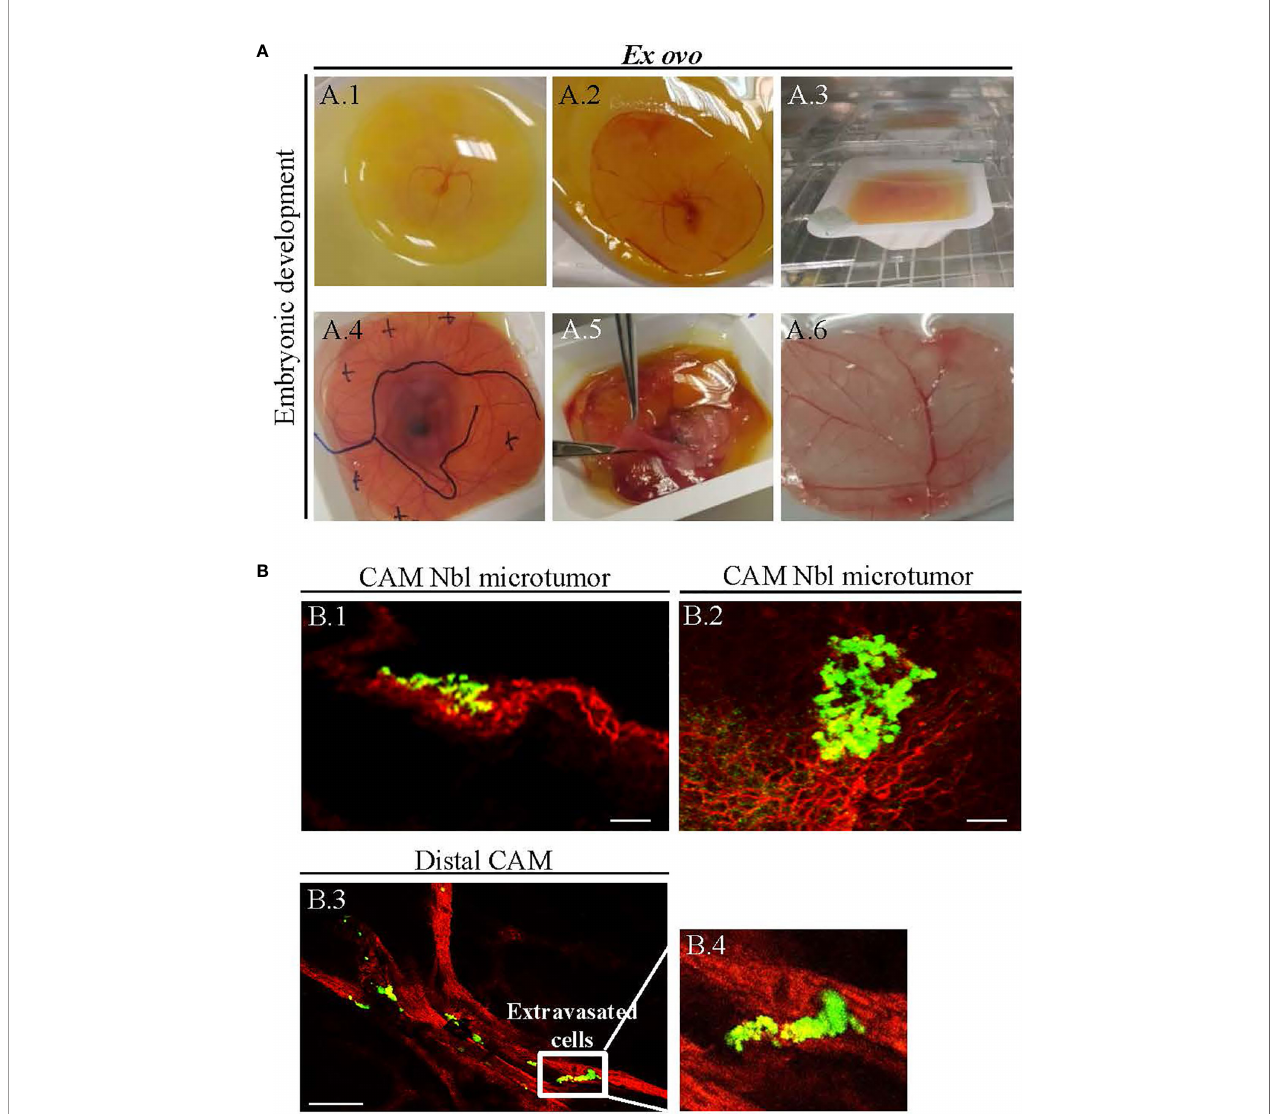
FIGURE 2 | (A) Ex ovo -cultivated chicken embryos exhibit physiological development over time. (A.1) Successful transfer of embryo having an intact egg yolk (on embryonic development day 3), and (A.2 – A.4) live embryo on embryonic development from day 3 to 10. (A.4) In vitro -cultured neuroblastoma (Nbl) cells were transferred on the chick chorioallantoic membrane (CAM) at day 10, and the sites of xenografting were marked on the cover of the Petri dish. (A.5) Harvesting of Nbl tumors from CAM at day 14. (A.6) The CAM fi xation for microscopy. (B) Confocal laser scanning microscopy (CLSM) validation of successful establishment of UKF- NB-4 xenografts on CAM. (B.1, B.2) Fluorescence angiography showing Nbl microtumors (green, labeled with CellTracker) surrounded by extensive amount of blood vessels [red, labeled with rhodamine Lens culinaris agglutinin (LCA)]. (B.3, B.4) Invasive vasculotropic Nbl cells that escaped from primary tumor site and extravasated at the distal CAM. Scale bars, 200 m